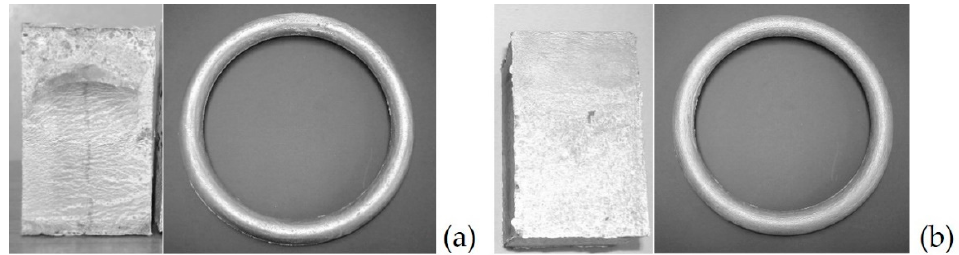
Figure 4. Foam block (80 × 50 × 50 mm 3 ) and a complex foam part (outer diameter: 250 mm) prepared by the uncontrolled cooling ( a ) and controlled cooling ( b ).